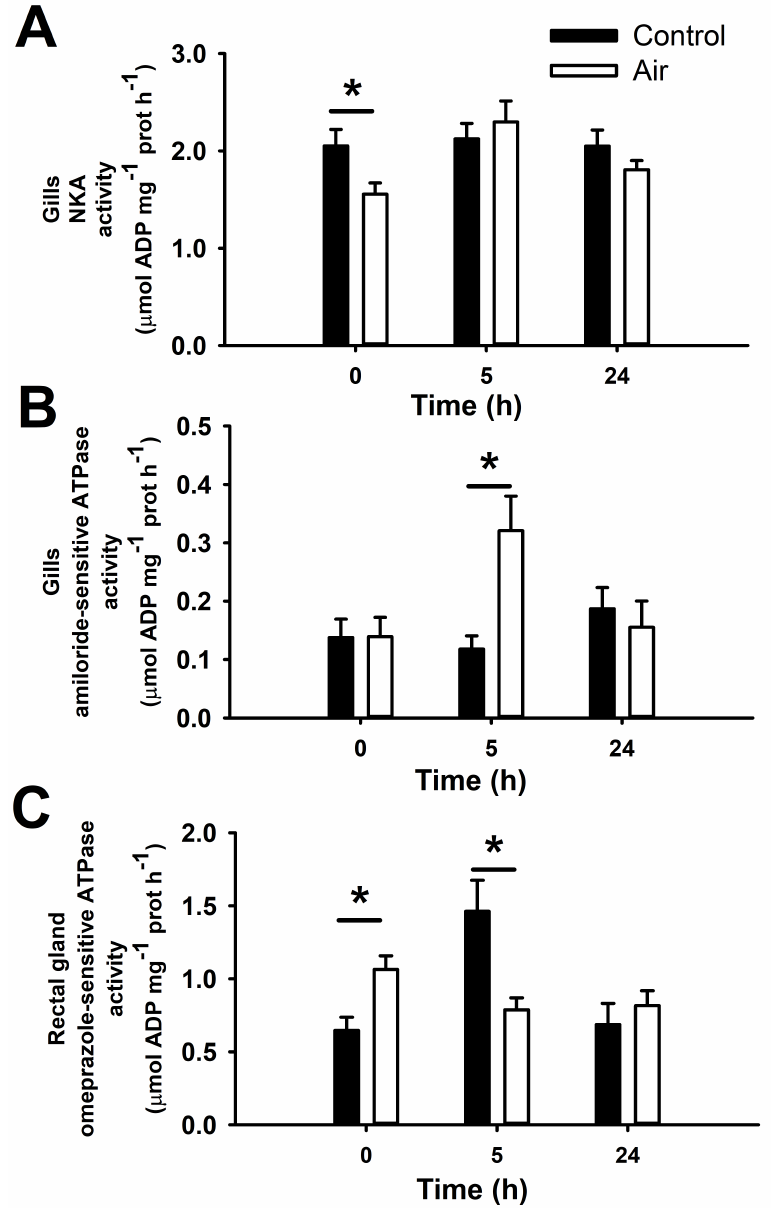
Figure 3. Gill Na + /K + -ATPase (NKA); ( A ), amiloride-sensitive ATPase (possibly a Na + /H + -exchanger from the NHE family); ( B ), and rectal gland omeprazole-sensitive ATPase (possibly a H + /K + -ATPase from the family HKA); and ( C ), activities in S. canicula after air exposure and recovery. Data are expressed as mean ± s.e.m. Asterisks (*) indicate significant differences between both groups at each time ( p < 0.05, n = 7–8).